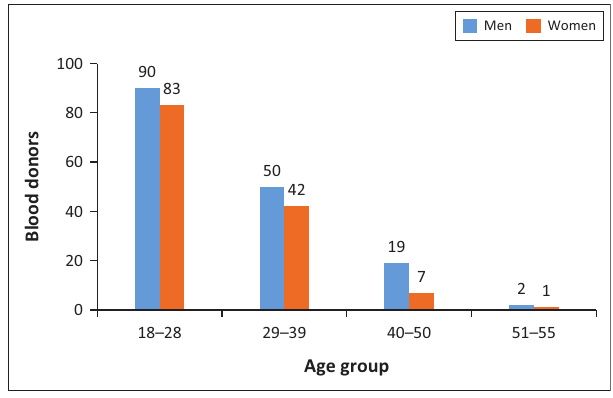
FIGURE 1: Distribution of study participants by age group, Yaoundé, Cameroon, November 2015 – September 2016.